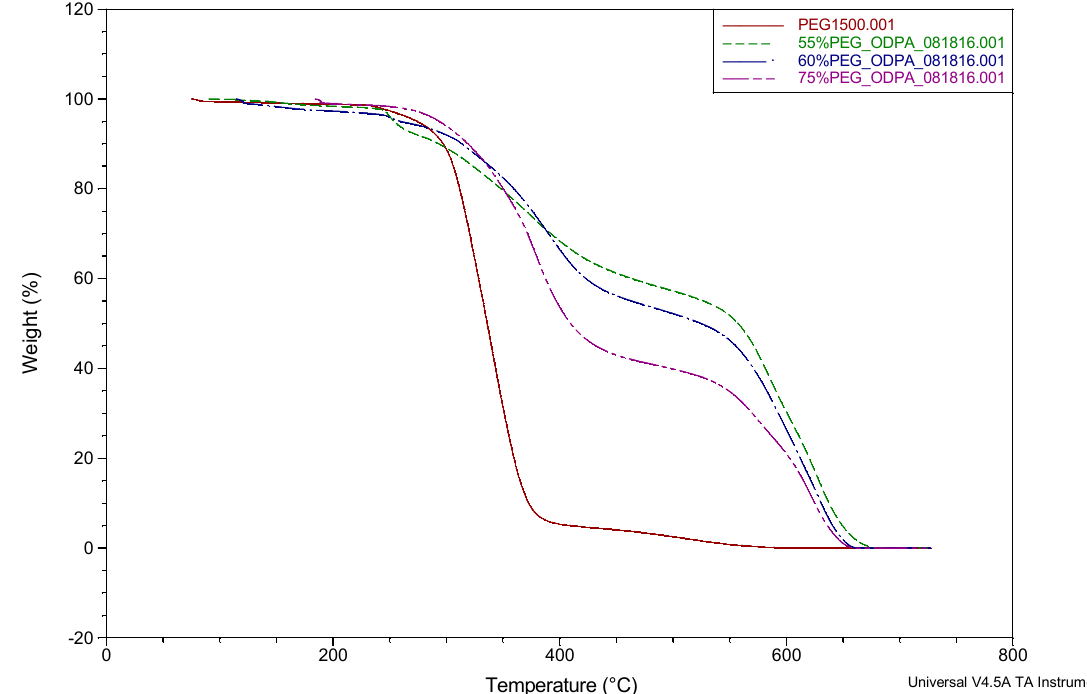
Figure 2. TGA of ODPA-PDODA-PEG1500 (changing PEG content) SBC membranes (percentages given in the figure for PEG content are mol%).